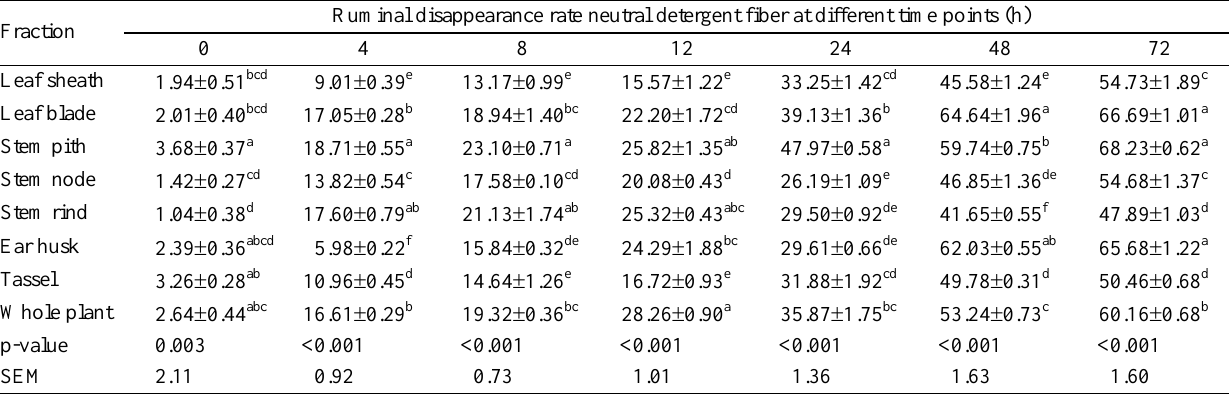
Table 3. Ruminal disappearance rate (%) of NDF from whole corn stover and different morphological